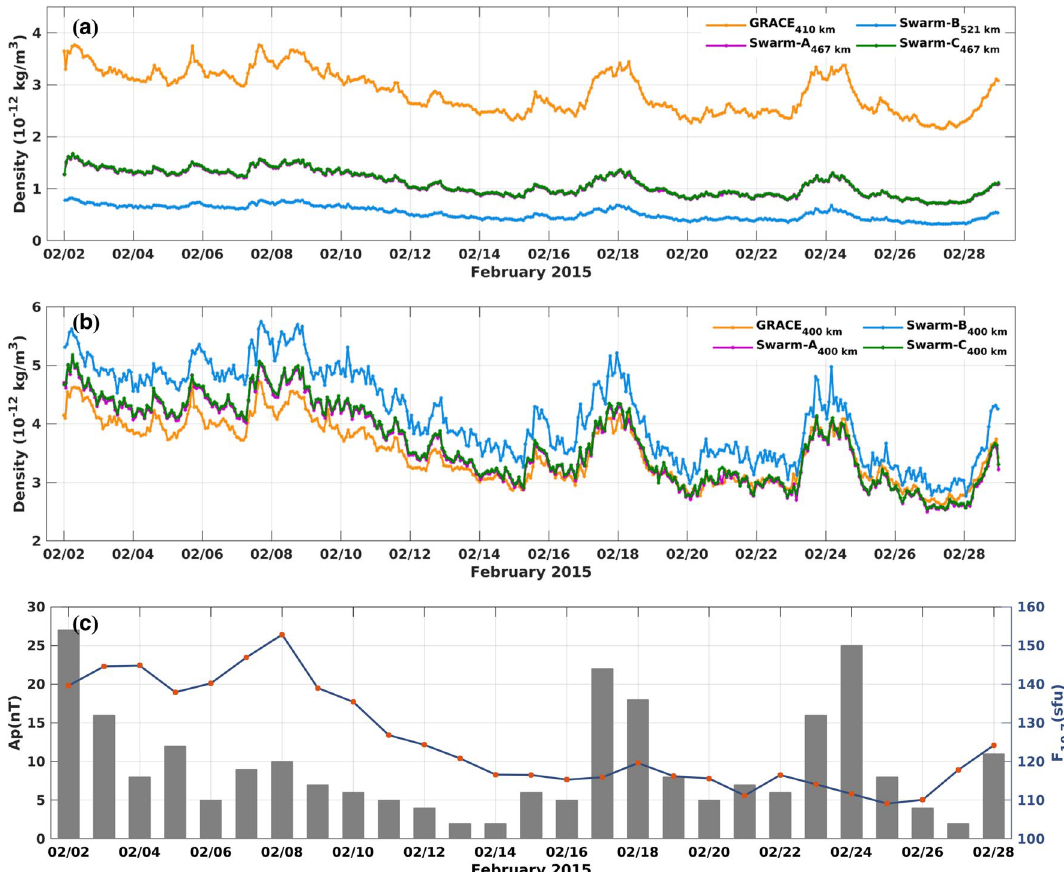
Figure 1. From top to bottom: ( a ) orbit-averaged TND from GRACE, Swarm-A, -B, and -C. on their original altitude. ( b ) Time series of orbit-averaged TND from GRACE, Swarm-A, -B, and -C normalised on a common altitude of 400 km. ( c ) Time series of the solar ( F 10.7 ) and geomagnetic activity ( Ap ) indices during February 2015. The plots were generated using MATLAB (version R2021a, https:// www. mathw orks.